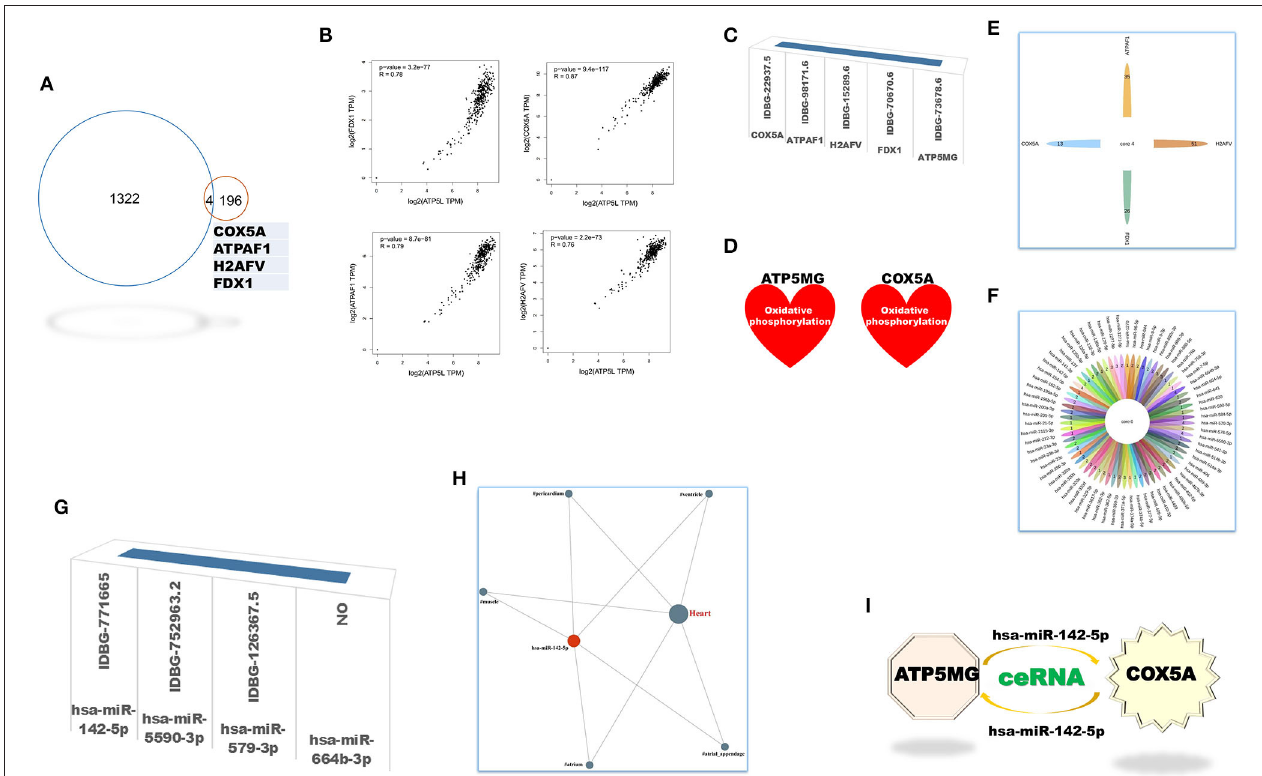
FIGURE 4 | Intersection genes between coRNA and ceRNA genes of ATP5MG. Only four sharing coding genes were dug out for coexpression gene sets and ceRNA gene sets of ATP5MG. These four cross coding genes shared four miRNAs. Metabolic and immune annotations were recovered and verified metabolic and immune roles of one coding gene and one miRNA for ATP5MG. (A) Genes numbers of distinct datasets. (B) Expression relations between ATP5MG and the intersection genes in the heart. (C) Four intersection genes besides ATP5MG were annotated in innateDB. (D) COX5A, and ATP5MG were annotated in the metabolic database. (E) miRNA gene numbers of four intersection genes. (F) Intersected miRNAs of four intersection genes. (G) Three intersection miRNAs except hsa-miR-664b-3p were annotated in innateDB. (H) Regulation network of hsamiR-142-5p in the heart. (I) ATP5MG-centered ceRNA subnetwork.